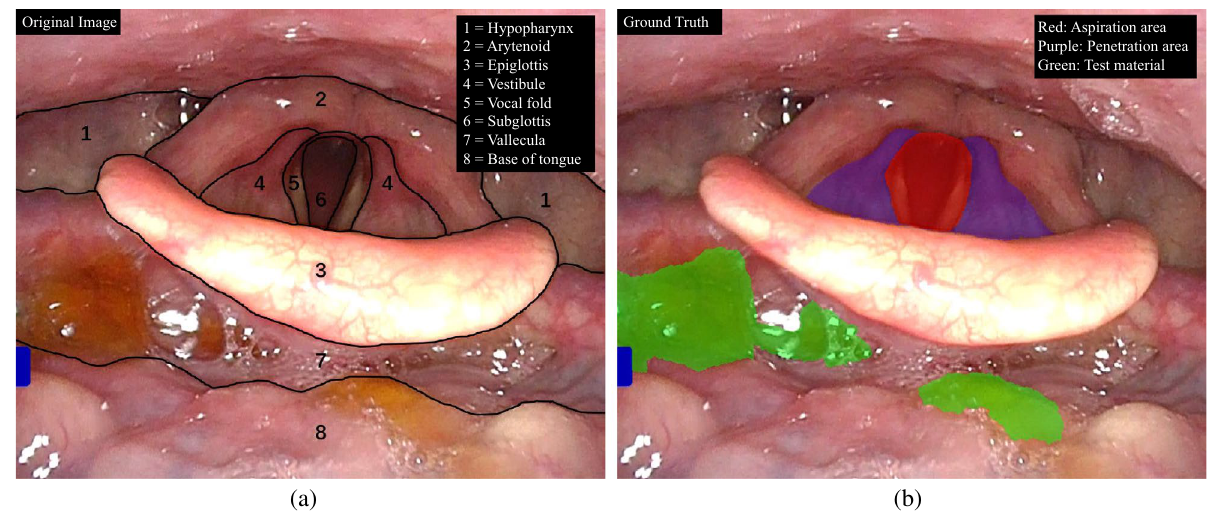
Figure 1. ( a ) Example of the original video frames. Outline of the eight different anatomic landmark structures in a FEES video: the hypopharynx (1), arytenoid (2), epiglottis (3), vestibule (4), vocal fold (5), subglottis (6), vallecula (7), and the base of the tongue (8). ( b ) Example of the segmentation video frames. Annotation of aspiration area (red) created by the two anatomic landmark structures of the vocal fold and